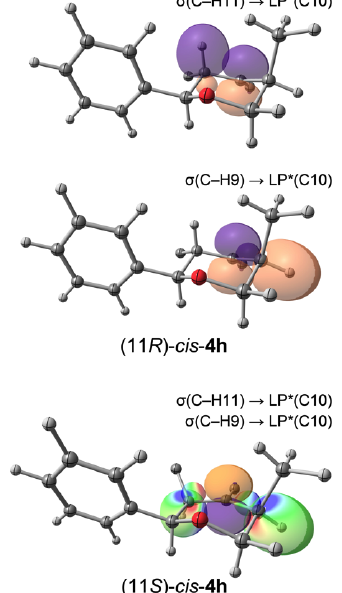
Figure 8. Relevant NBOs for the stablization of cis - 4h . Some atoms were removed for clarity. Color mapped surfaces indicate orbital superposition in red and blue; contour value: